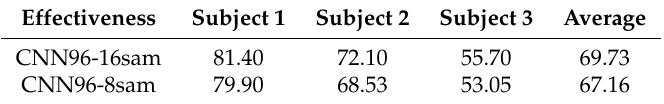
Table 3. Effectiveness of the method (in %).